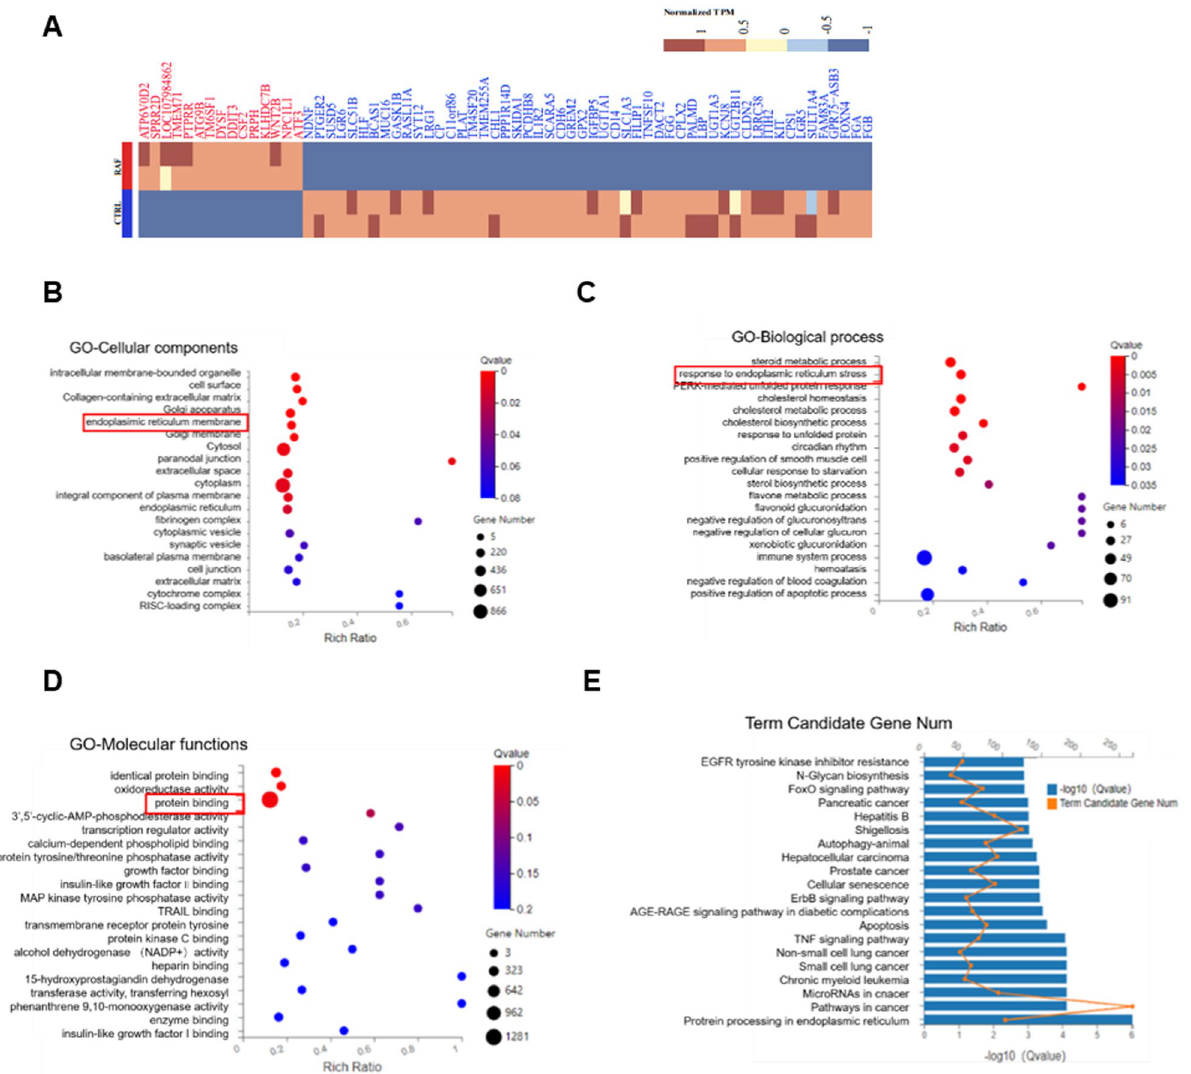
Figure 3. RNA-seq analysis of the ERs response upon rafoxanide treatment. ( A ) Heatmap of DEGs of A549 cells challenged with DMSO or rafoxanide. ( B–D ) GO classification of rafoxanide-regulated DEGs on the Dr. Tom platform (BGI-tech, China). The x -axis indicates the proportion and the y-axis indicates GO classification. ( E ) KEGG pathway enrichment analysis of DEGs. The x -axis indicates the proportion and the y-axis shows the KEGG pathway